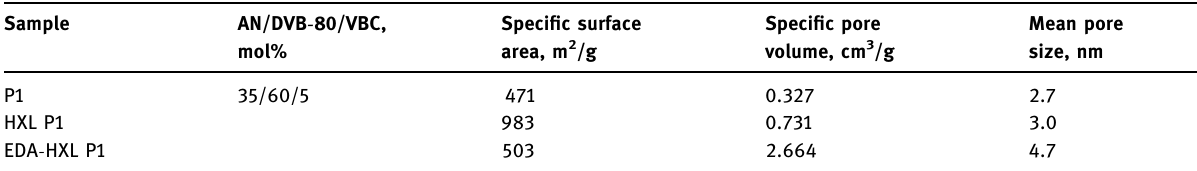
Table 3: BET data of poly ( AN - co - DVB - 80 - co - VBC ) and hypercrosslinked poly ( AN - co - DVB - 80 - co - VBC ) terpolymers before and after the chemical modi fi cation with EDA